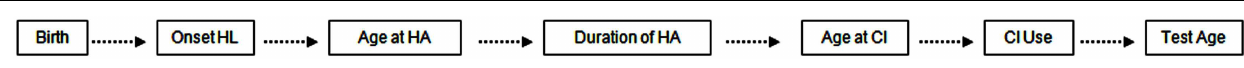
to implantation were unavailable in four children; however, in all cases, unaided thresholds before and after cochlear implantation confirmed profound bilateral hearing loss.